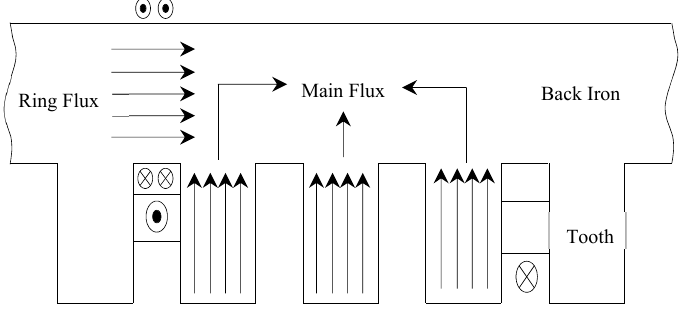
Figure 15. Schematic View of Stator core carrying main and ring flux.